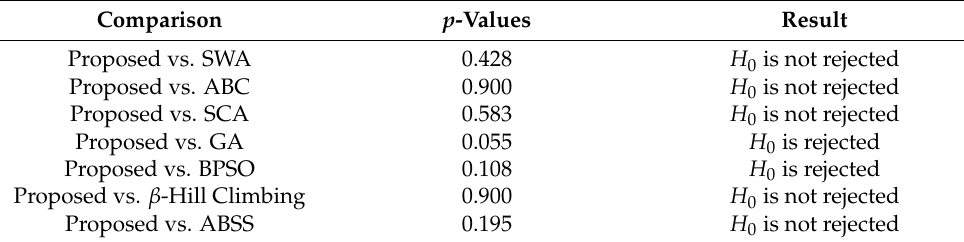
Table 5. Average rankings of MSE among 8 algorithms on three datasets using Friedman test. Proposed SWA ABC SCA GA BPSO Rank 1 5.17 2.67 4.67 7 6.5 3 6 Table 6. Post hoc Holm test (0.1). Comparison p -Values Result Proposed vs. SWA 0.428 H 0 is not rejected Proposed vs. ABC 0.900 H 0 is not rejected Proposed vs. SCA 0.583 H 0 is not rejected Proposed vs. GA 0.055 H 0 is rejected Proposed vs. BPSO 0.108 H 0 is rejected Proposed vs. β -Hill Climbing